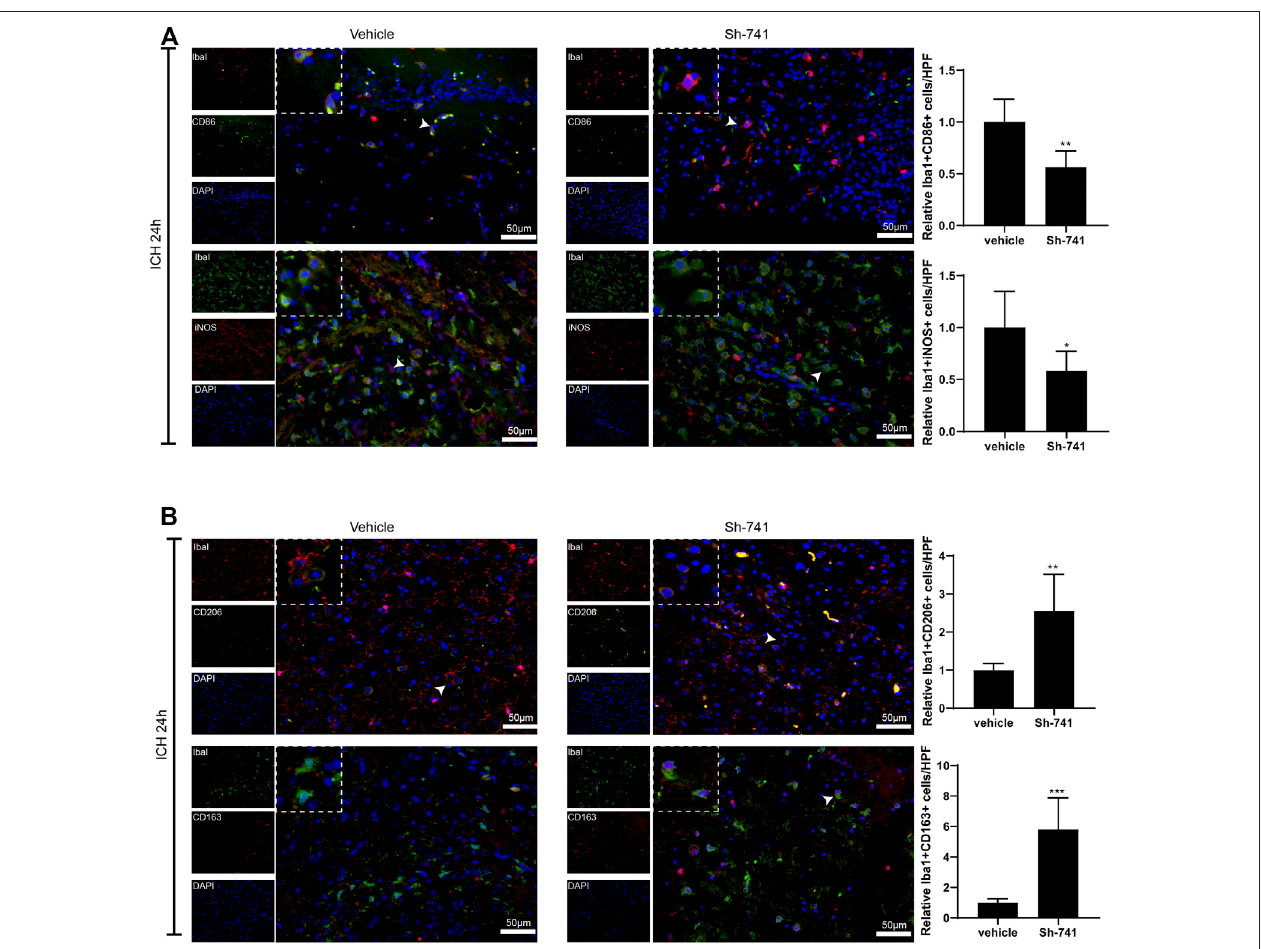
FIGURE7| TCONS_00145741 affects the activation ofmicroglia inICH. (Aand – B) 24 hafter the establishment ofthemouse ICH model, theactivationofmouse microglia was assessed using an immuno fl uorescence assay (Scale bar (cid:2) 50 μ m). * p < 0.05, ** p < 0.01, *** p < 0.001 vs. vehicle.